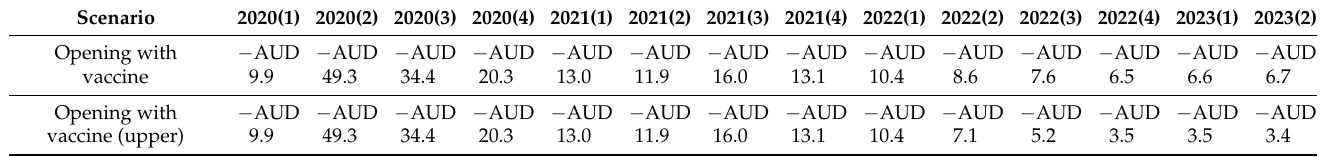
Table A2. AUD bn change in Australian GDP with and without vaccine vs. no COVID